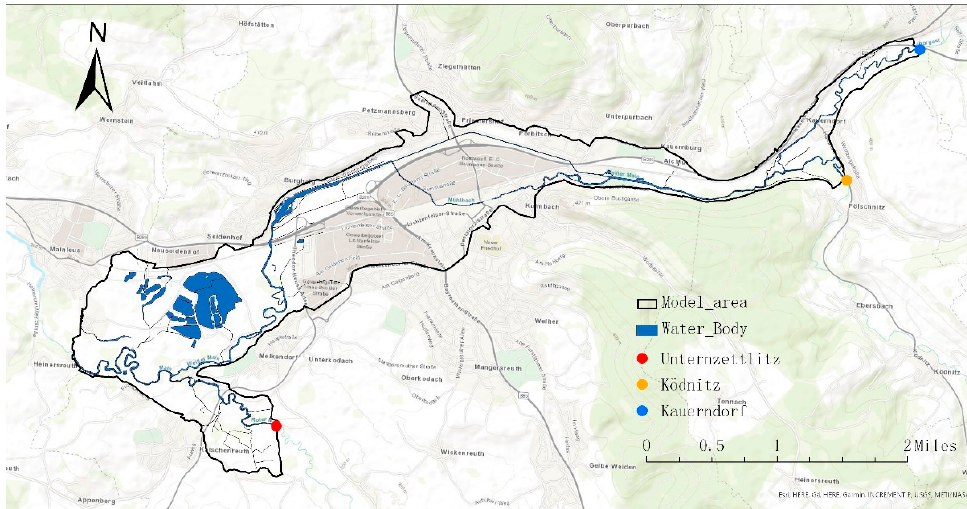
Figure 5. Gauges and rivers of the study area of Kulmbach.